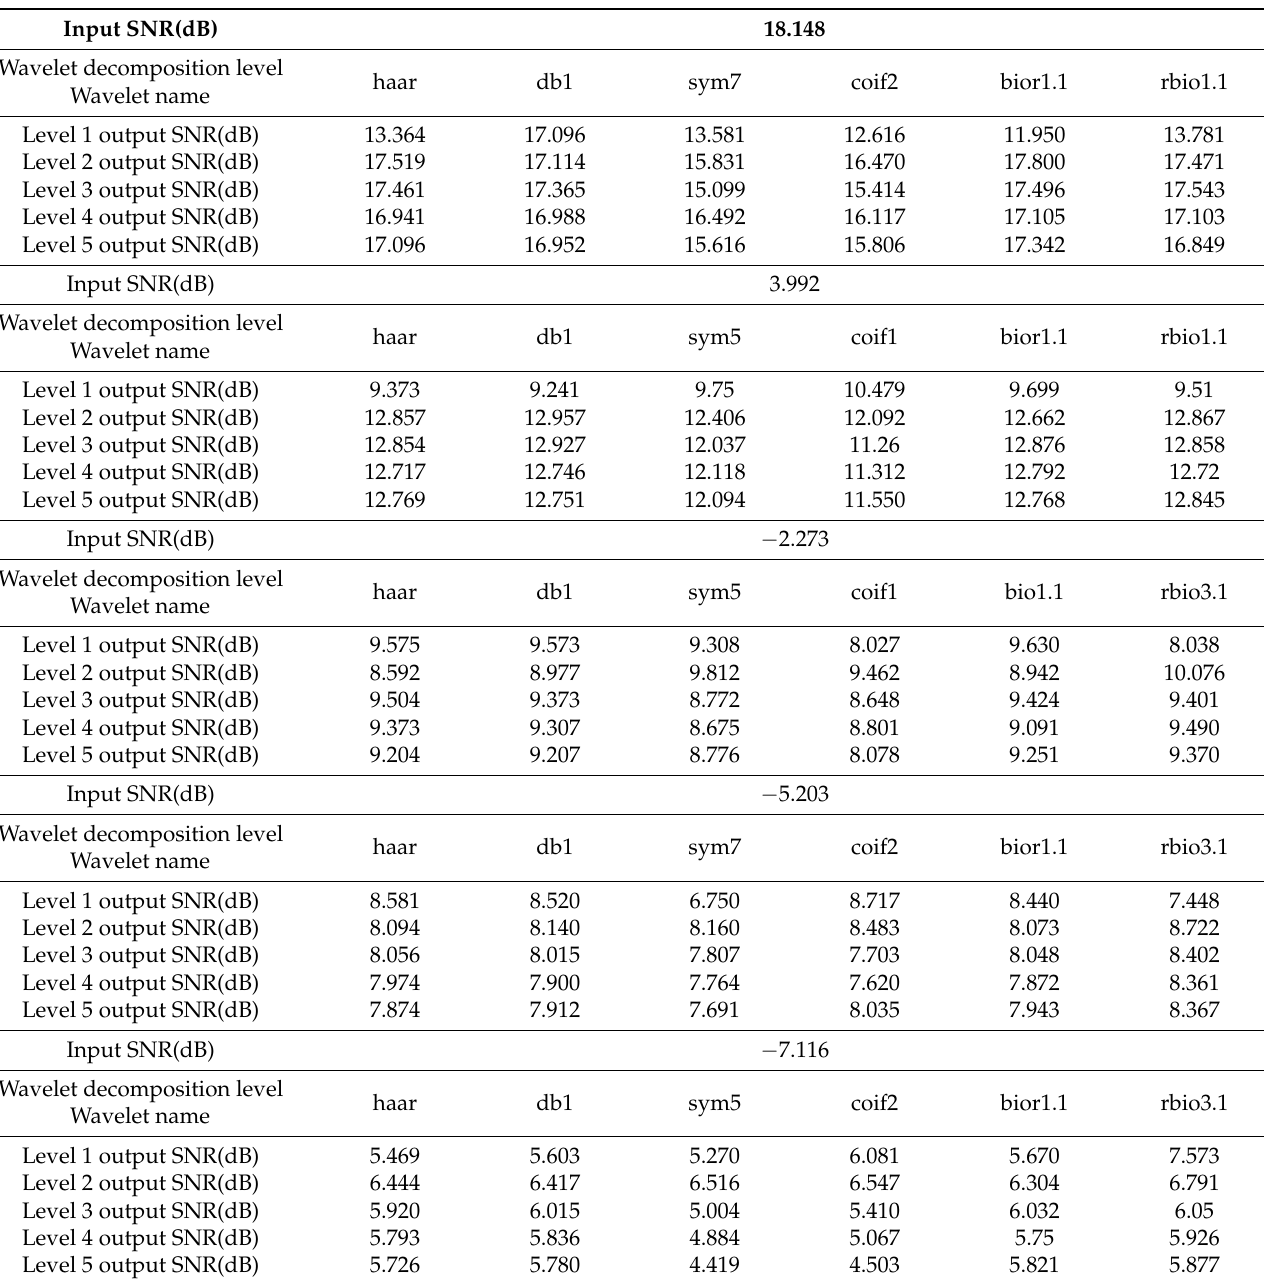
Table 3. DWT-Resnet18 denoising results for real seismic data with different noise levels, using different wavelet basis functions, and at different wavelet decomposition